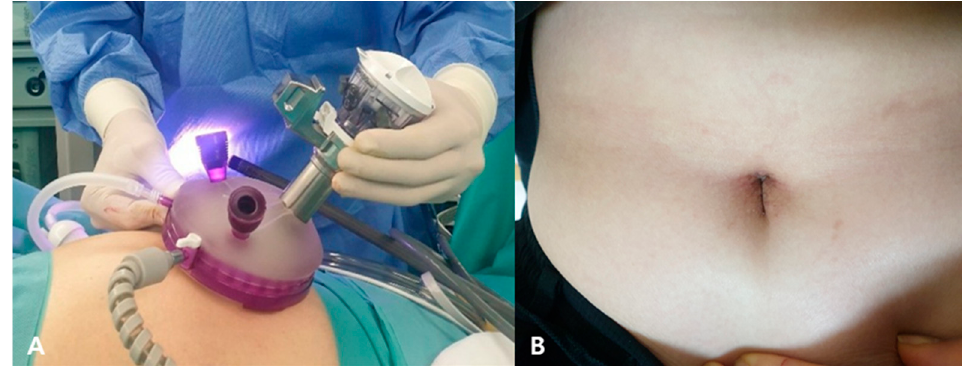
Figure 1. Single 25–27 mm intraumbilical incision was made and a multichannel single port was used in the single-incision robotic approach, Single-Port system in this case ( A ) Intraoperative ( B ) Postoperative 2 weeks follow-up visit.